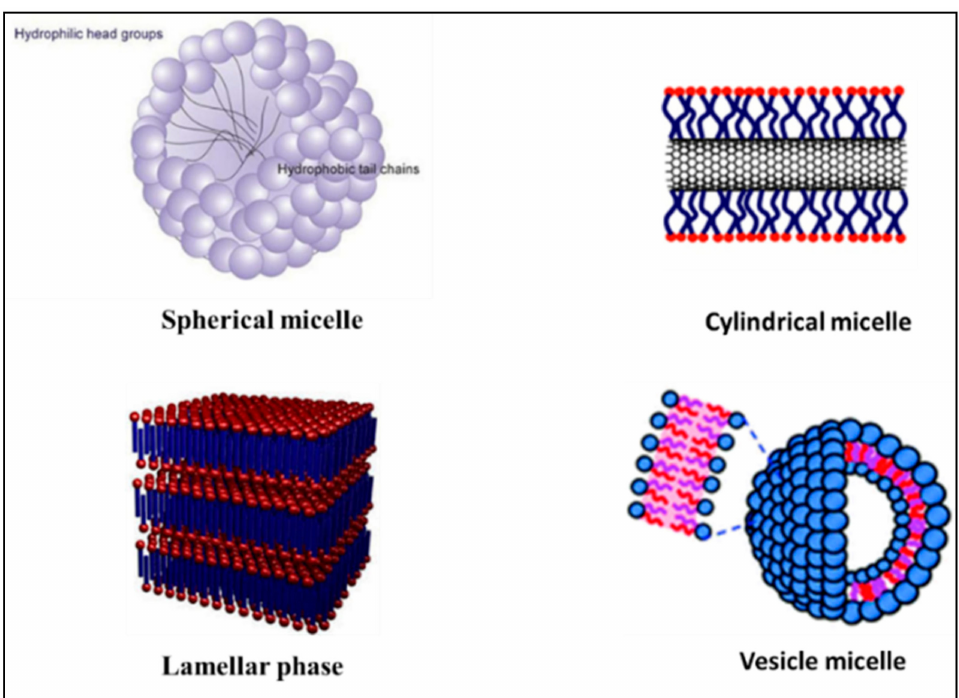
Figure 2. Illustration of some different self-assembled micelles structure. Reprinted with permission from [41]. Copyright © 2017, The Royal Society of